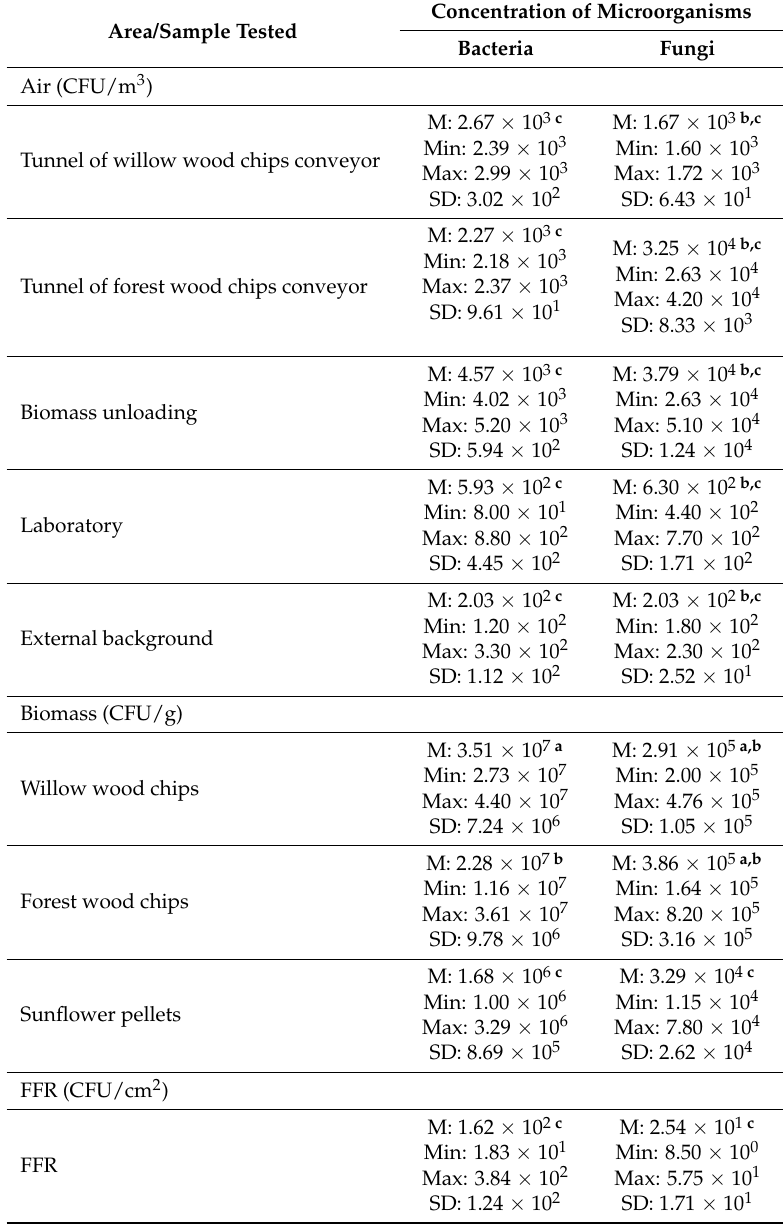
Table 4. Concentration of microorganisms isolated from the air, biomass samples and filtering facepiece respirators